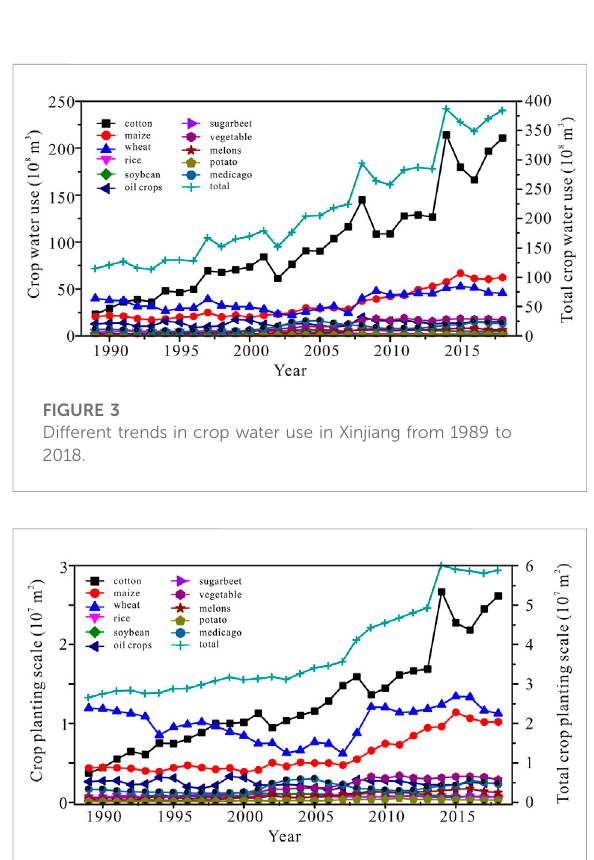
FIGURE 4 Crop planting scale trends in Xinjiang from 1989 to